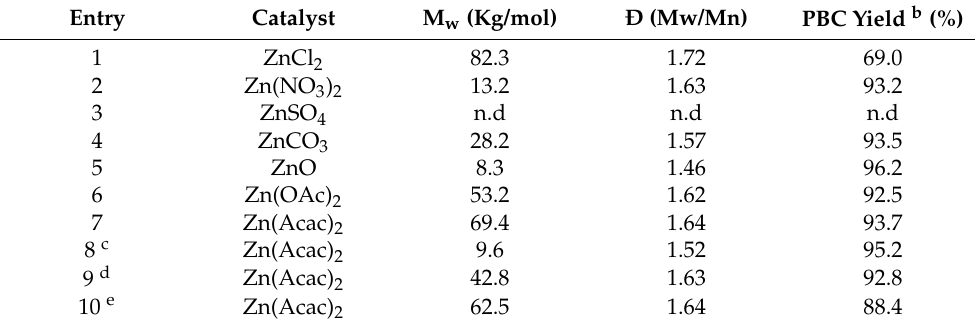
Table 1. The catalytic performance of various zinc-based catalysts for the condensation polymeriza- tion of BD and DPC to PBC a